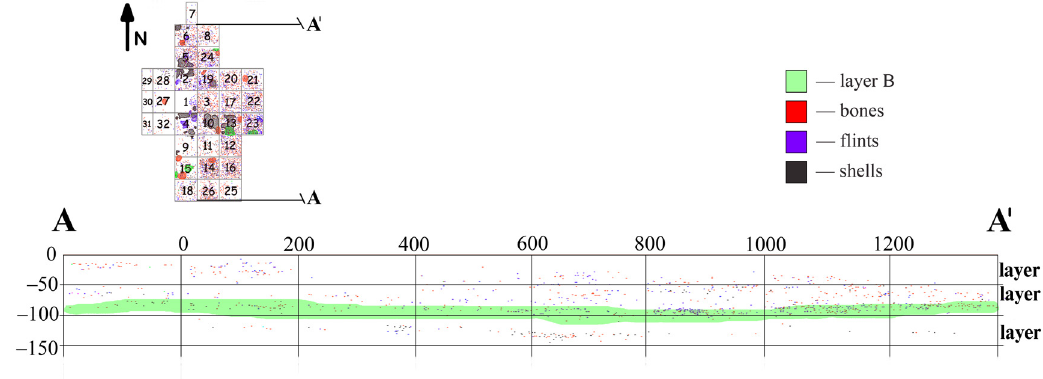
Figure 4: Pro fi le across 3D cloud of points from excavation trench 2 with indication of the layer B ( in green ) .